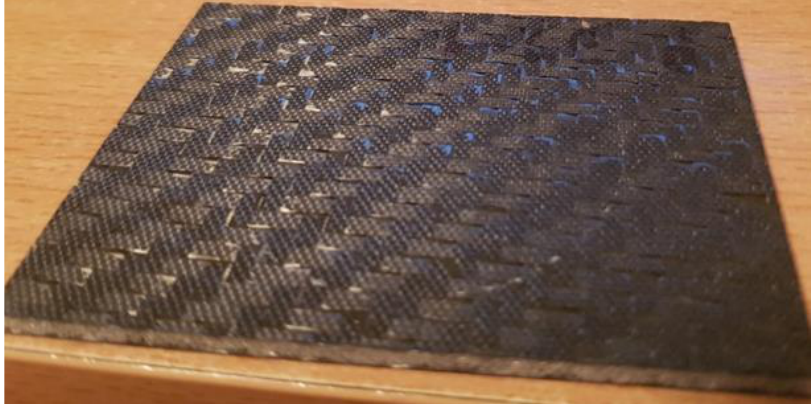
Figure 7. Airex core composite with visible 3 J load mark — from the side of load application.